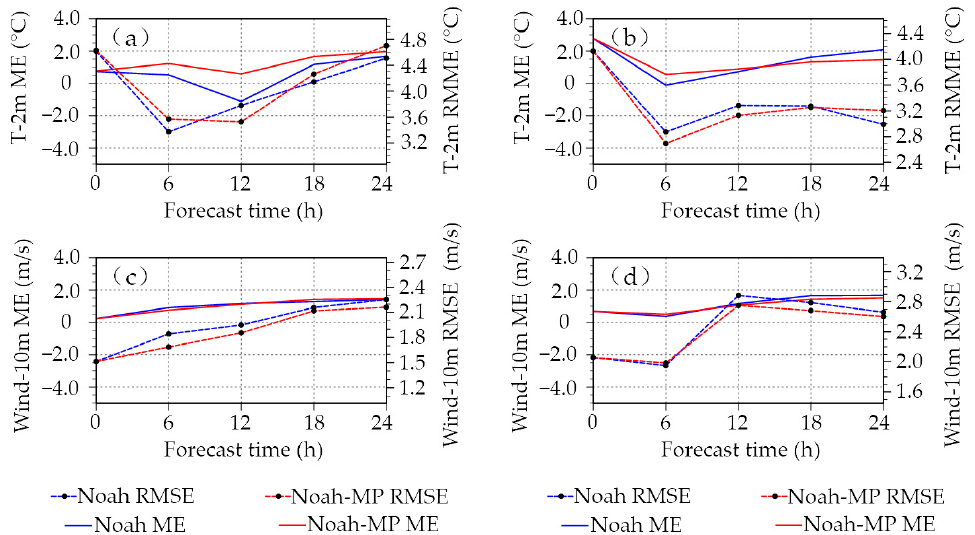
Figure 10. Time series of monthly ME (solid line) and RMSE (dashed line) of simulated near-surface variables with Noah and Noah-MP scheme: 2-m temperature ( a , b ) and10-m wind speed ( c , d ) in January ( a , c ) and July ( b , d ) 2017.